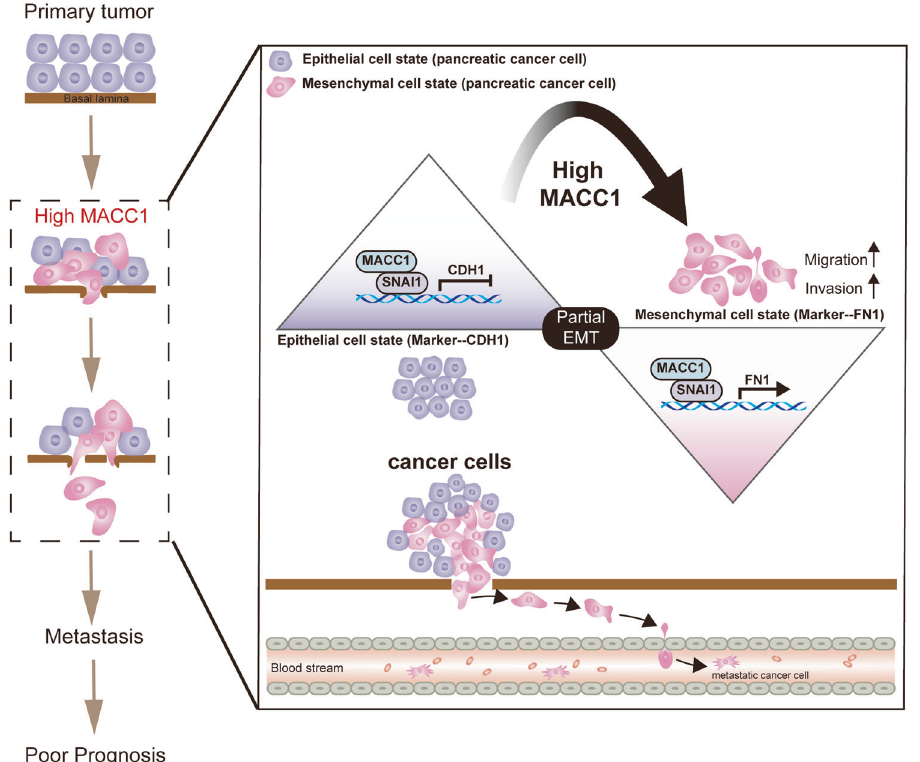
Fig. 7 Proposed model for the role of MACC1 on PC metastasis. MACC1 functions as an EMT driver by interacting with SNAI1 to promote the transition of primary cancer cells from the epithelial to the mesenchymal cell state, which drived the EMT program and accelerated the metastasis of pancreatic cancer, and ultimately in fl uenced the patient outcome. On the one hand, the MACC1-SNAI1 complex binds to the CDH1 promoter, inhibits the expression of the epithelial cell marker CDH1, and promotes the loss of the epithelial phenotype of cancer cells. On the other hand, the MACC1-SNAI1 complex binds to the FN1 promoter and promotes the expression of the mesenchymal marker FN1, which further facilitates the transition of cancer cells to the mesenchymal cell state and ultimately accelerated the metastasis of pancreatic